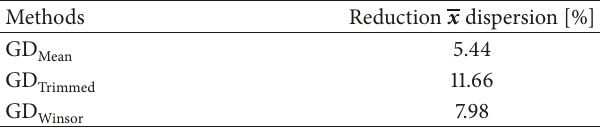
Table 40: Exponential with 100 points.